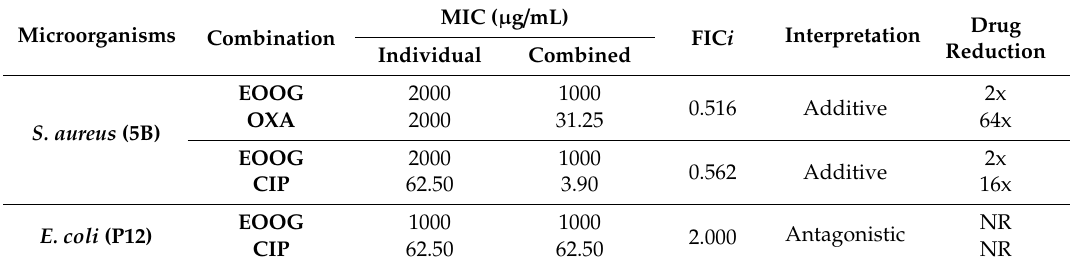
Table 3. Fractional inhibitory concentrations index (FIC i ) of OXA and CIP combined with EOOG for S. aureus (5B) and E. coli (P12) microorganisms.